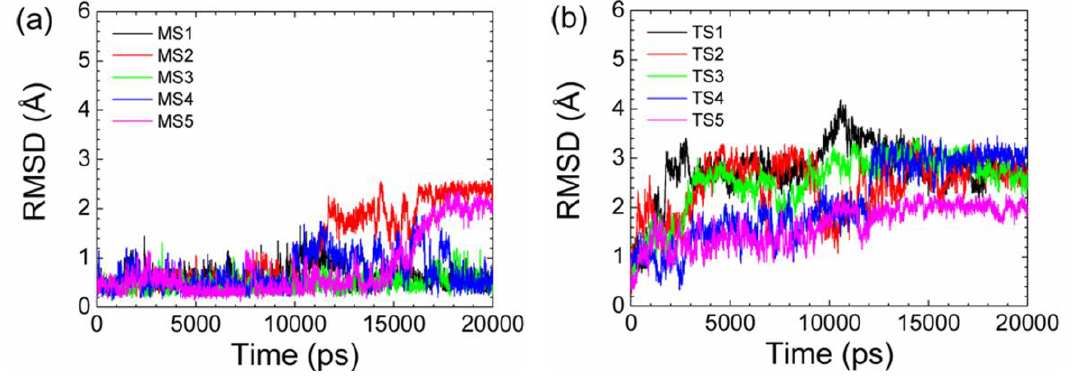
Figure 2. RMSD relative to the backbone of the helical region (Phe19–Leu26) for p53N from p53N-MDM2 ( a ) and from p53-Taz2 ( b ) during the simulations. Simulation trajectories MS1–MS5 and TS1–TS5 are